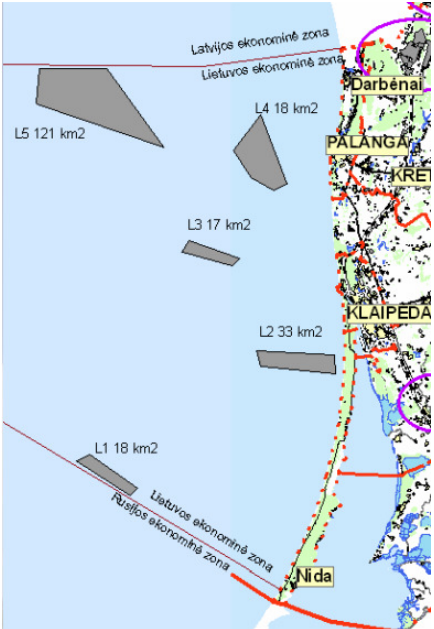
Fig. 2. Possible places for constructing wind power plants in the sea (Klaipėda Science and Technology Park 2010)